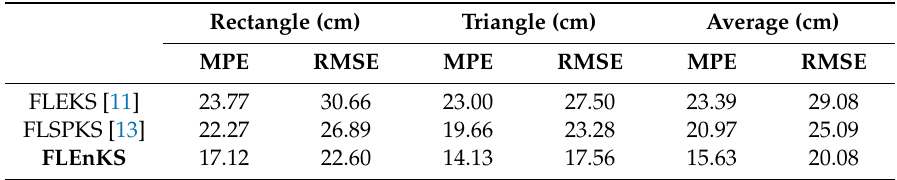
Table 4. MPE and RMSE of Di ff erent Smoothers. FLEKS: Fixed-Lag Extended Kalman Smoother, FLSPKS: Fixed-Lag Sigma-Point Kalman Smoother.